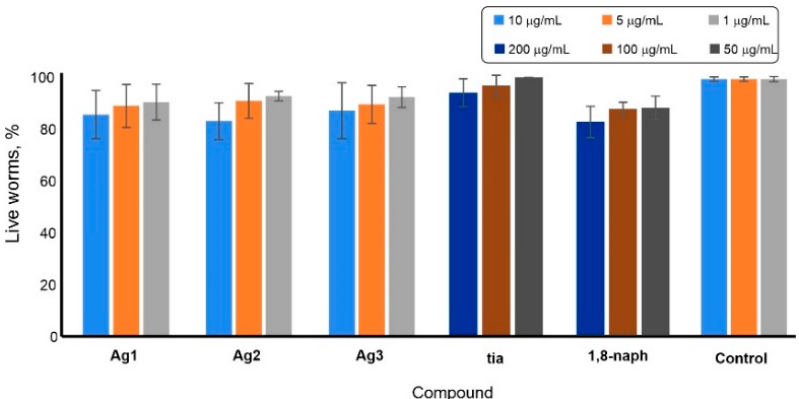
Figure 5. Survival of C. elegans in the presence of silver(I) complexes Ag1 – 3 alongside tia and 1,8- naph ligands (%, average ± the SD) after 48 h of treatment. ligands (%, average ± the SD) after 48 h of